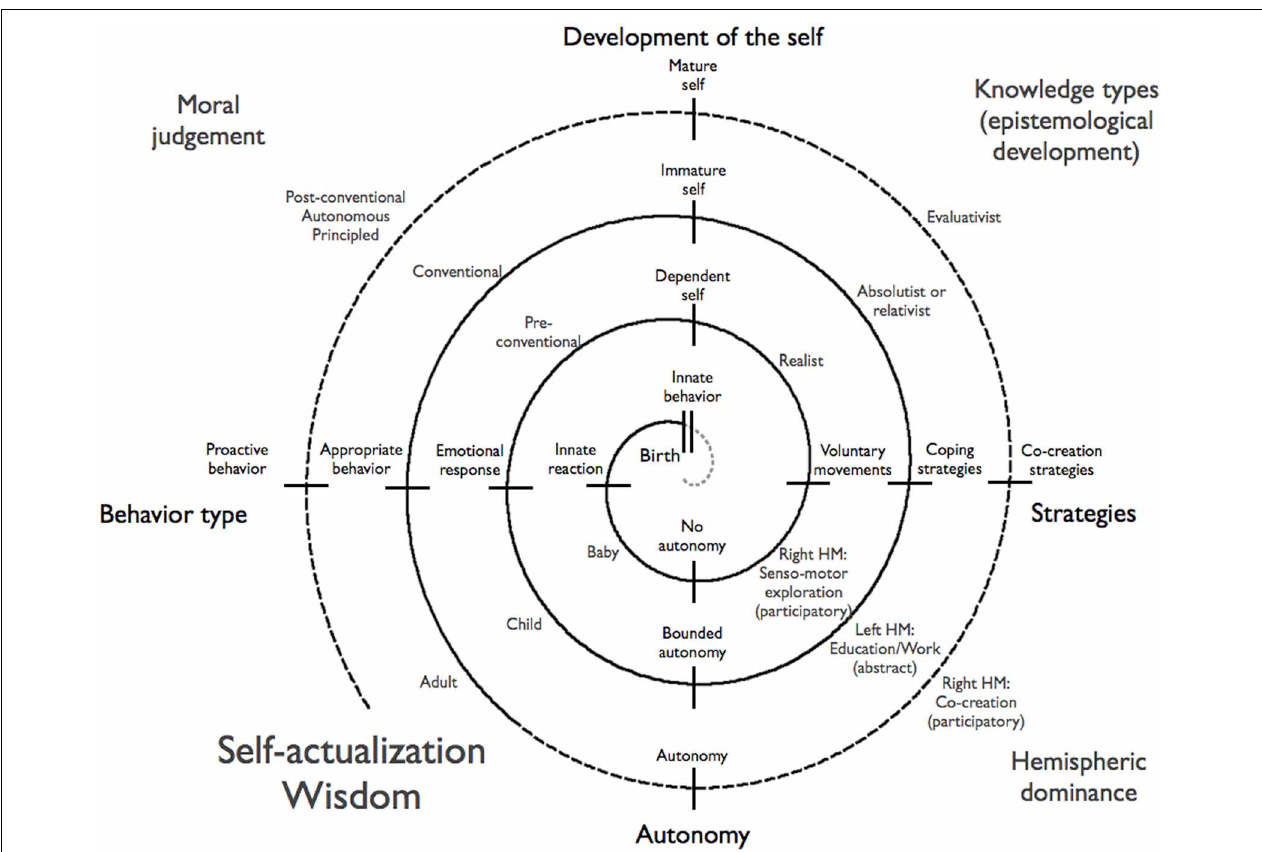
FIGURE 1 | Open-ended development. This spiral development depicts phases in open-ended development and terms typically associated with different development phases. The inner rotation can be described as learning to master the body, the second rotation as making the mind a